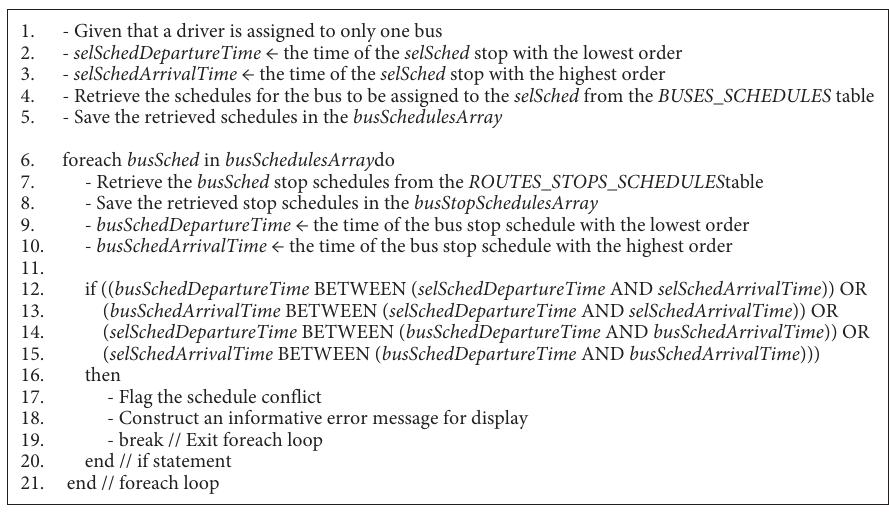
Figure 18: The pseudocode for the schedule conflict detection